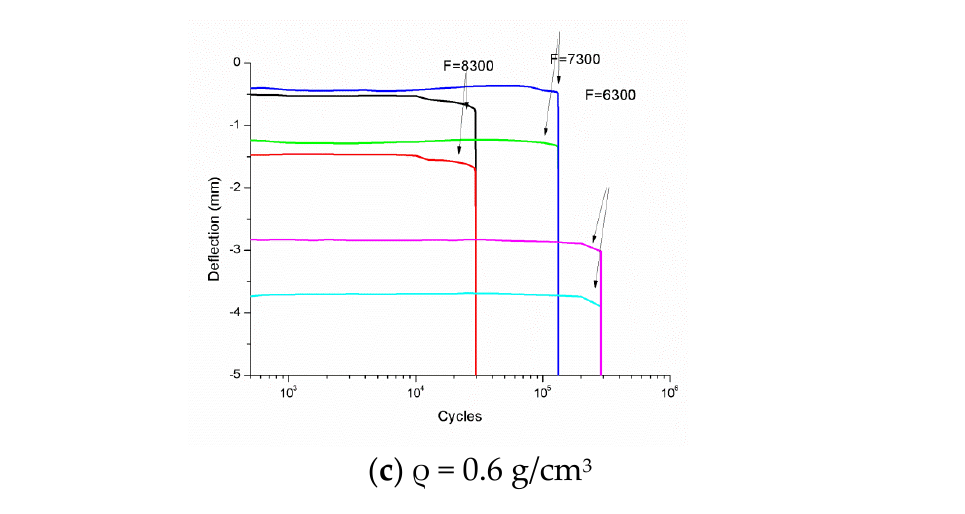
Figure 5. Hysteretic behavior of the tested aluminum foam sandwich.